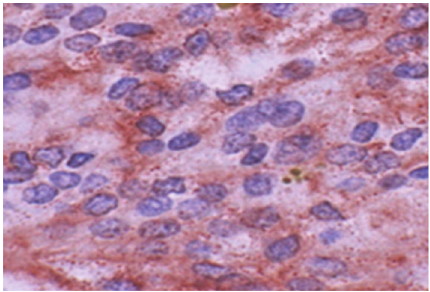
Figure 5: All tumor cells showed strong di ff use red pancytoplasmic homogenous to slight granular positive staining for CD117